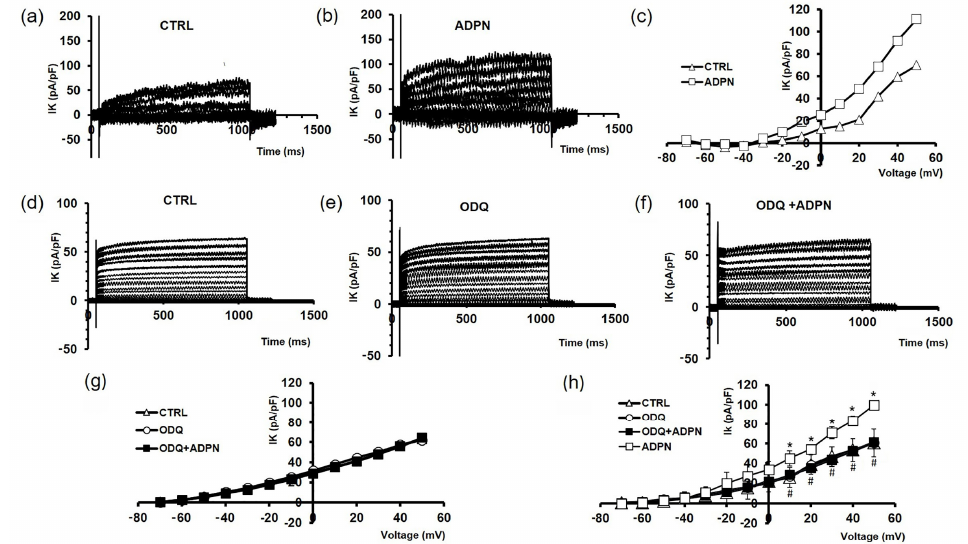
Figure 3. The effects of adiponectin (ADPN) on outward K + currents evoked in the smooth muscle cell (SMCs) from the gastric fundus involve guanylate cyclase (GC) activity. Representative family of outward K + currents evoked by voltage steps from − 80 to +50 mV (holding potential, HP = − 60 mV) in 10 μ M-nifedipine- and 1 μ M-tetrodotoxin-containing solution in the untreated sample (CTRL) ( a ), and in the presence of 20 nM ADPN ( b ). The representative ( c ) I–V plot related to the two conditions is shown in ( a , b ) (open triangles, CTRL; open squares, ADPN). ( d ) Representative K + current traces were obtained from a different untreated SMC (CTRL) in the presence of guanylate cyclase inhibitor ODQ 1 μ M ( e ) and in the presence of ODQ + ADPN ( f ). The representative ( g ) I–V plot related to the three conditions is shown in ( e – f ) (open triangles, CTRL; open circles, ODQ; filled squares, ODQ + ADPN). All of the current values are normalized to cell capacitance (Cm) and are indicated in pA/pF. ( h ) I–V plots related to all of the experiments done in the four different conditions are here reported together for a better comparison: CTRL (open up triangles, n = 6); ADPN (open squares, n = 5); ODQ (open circles, n = 4); ADPN in the presence of ODQ (ODQ + ADPN, filled squares, n = 4). Data are expressed as mean ± SD. * p < 0.05 vs. CTRL; # p < 0.05 vs. ADPN. No statistically significant differences were observed between CTRL, ODQ, and ODQ + ADPN (one-way ANOVA with Bonferroni’s correction; p > 0.05).